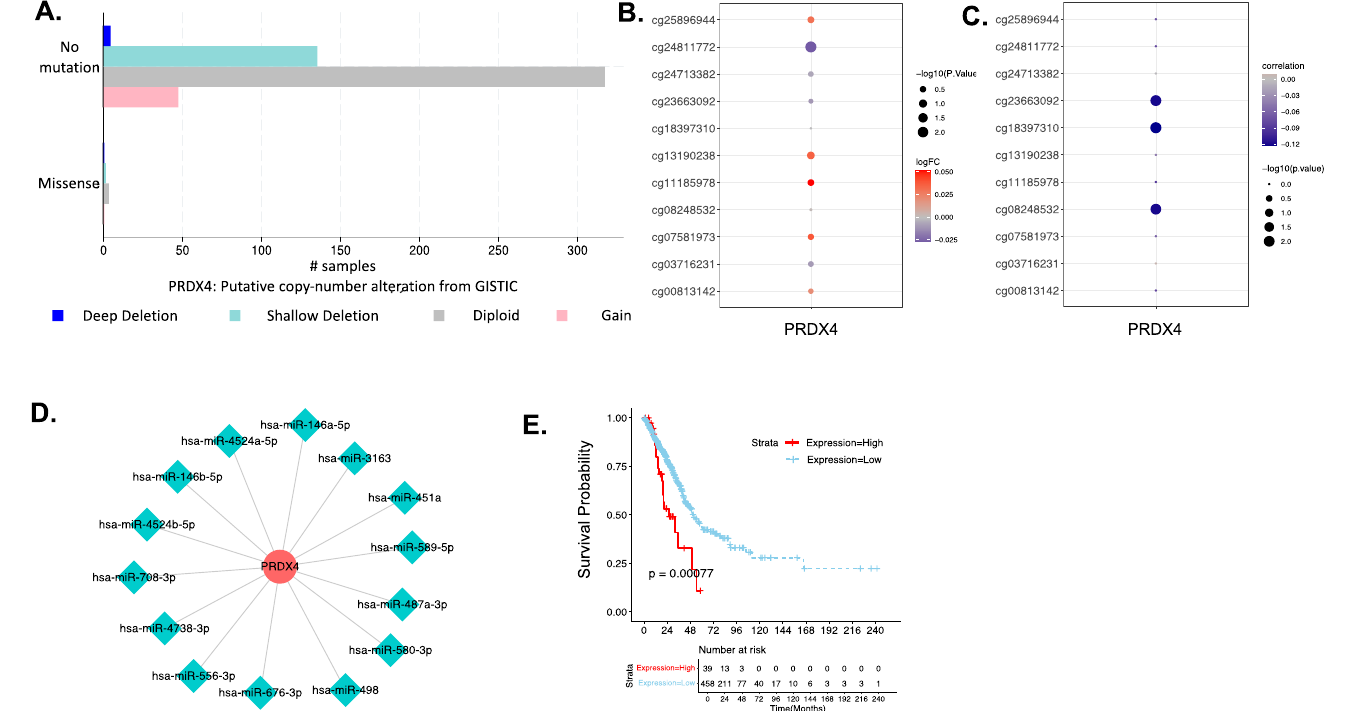
(Table 3). The combined results of the two databases yielded a total of 14 miRNA-mRNA regulatory relationship pairs, and the miRNA- mRNA regulatory network is shown in Figure 6D. The miRNA expression data of LUAD cases in the TCGA database were matched with the above 14 miRNAs, and a total of 12 miRNA expression data were obtained. Uni- variate cox regression analysis yielded 1 miRNA: hsa-miR-3163 (Table 4). The 497 patients were divided into hsa-miR-3163 high expression group (39 patients) and hsa-miR-3163 low expression group (458 patients) according to the mean of hsa-miR-3163 expression. The results of K-M curve analysis showed that hsa-miR-3163 high/low expression groups were significantly correlated with OS (Figure 6E), thus hsa-miR-3163 was predicted as a key miRNA in the post-transcriptional regulation of PRX4 affecting prognosis of LUAD.